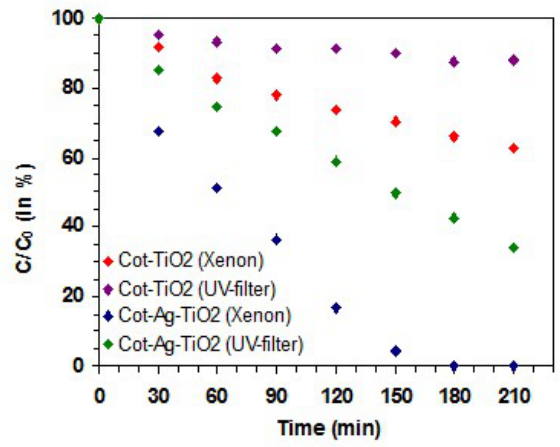
Figure 6: Evolution of the RB concentration of an aqueous solution in presence of a piece of modified cotton, Cotton-TiO Ag-TiO immersed in the RB solution under a Xenon lamp, in the 2 presence or in absence of a UV-filter [30]; reprinted with permission from Elsevier